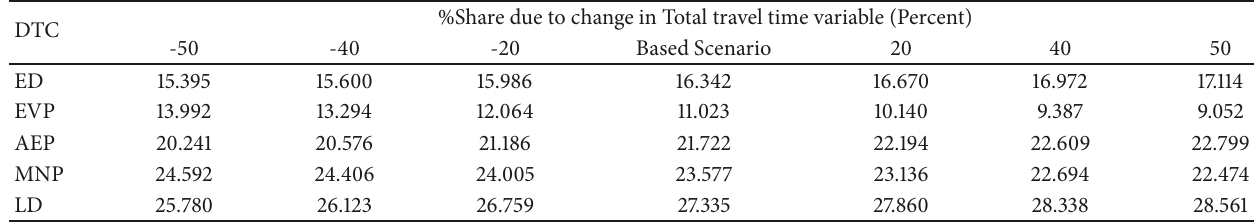
Table 4: Sensitivity analysis of the MNL-DTC model due to total travel time